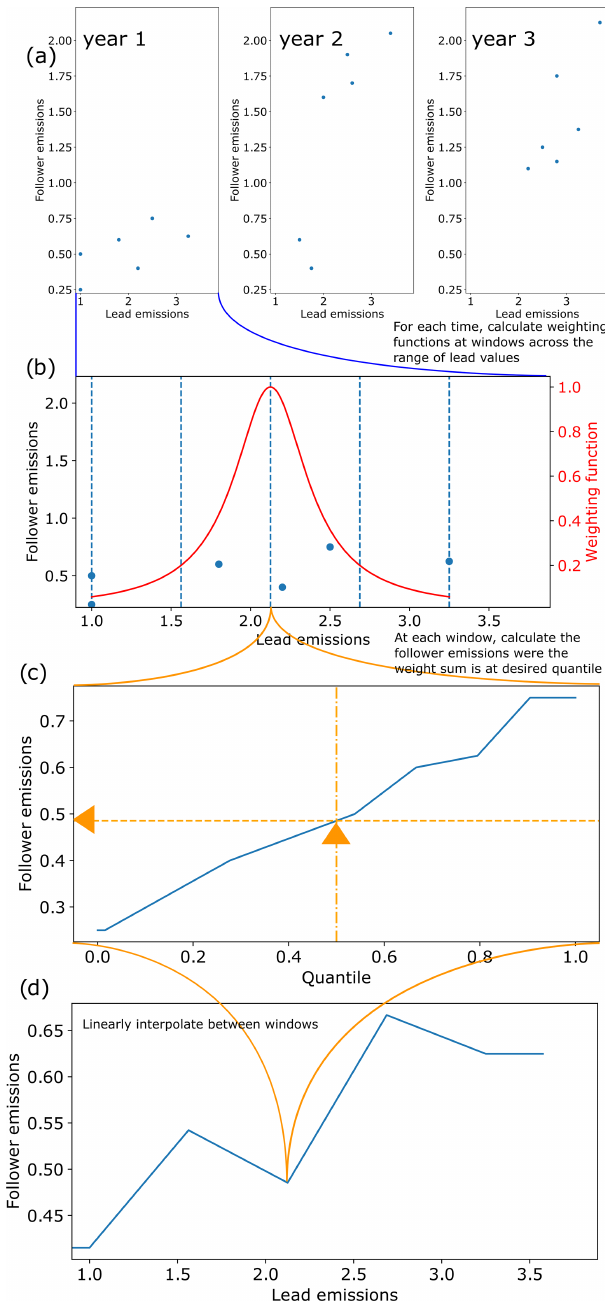
Figure 2. Schematic of how the quantile-rolling-windows cruncher determines the follower value to use. (a) Example relationships be- tween lead (CO 2 ) and follower (CH 4 ) variables over time. (b) A number of rolling window centres (here 5, by default 10) are drawn, and a weighting function is constructed for each window. It has a continuous distribution rather than a discrete cutoff, hence the name. (c) A relationship between the sum of the weights and the follower value is established, and the follower value at the desired quantile is